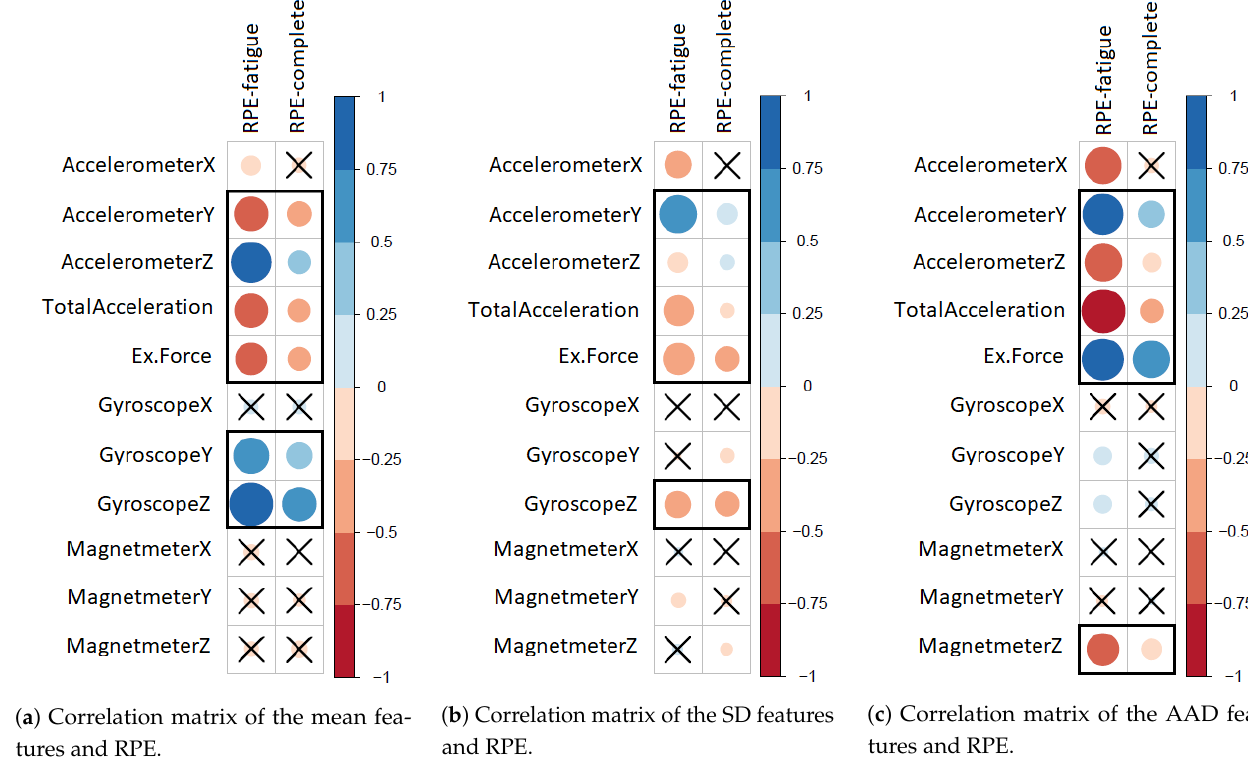
( b ) Correlation matrix of the SD features ( a ) Correlation matrix of the mean fea- and RPE. tures and RPE. Figure 5. Graphical display of the differences in the correlation matrices of the 33 extracted features (mean, SD, AAD) and the RPE values in the fatigue subset and our complete dataset.